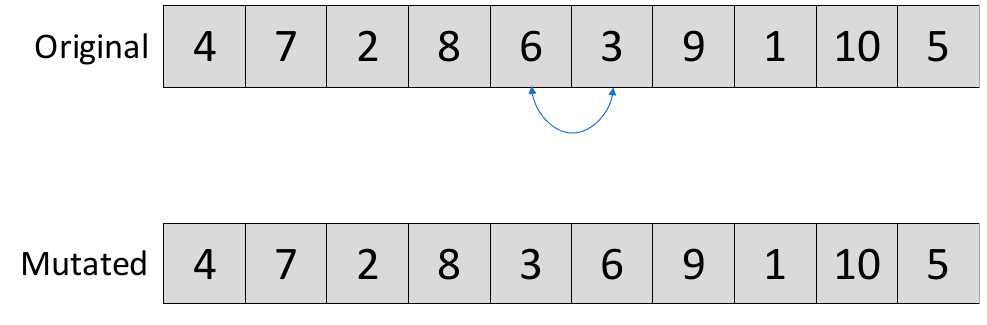
Figure 2. A simple mutation.